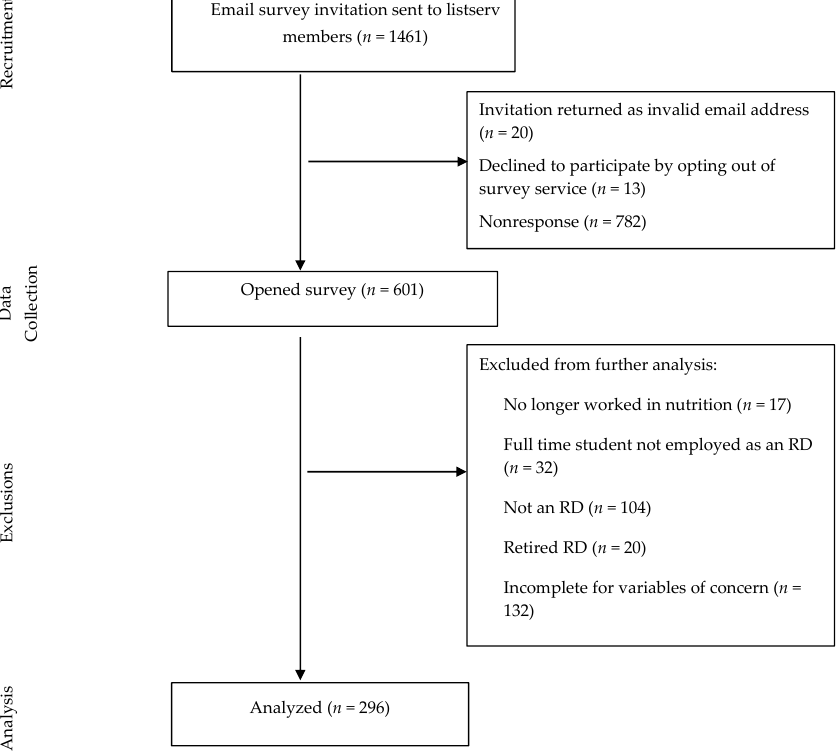
Figure 1. Consort flow diagram for participants of the Arizona Registered Dietitian Bean Health Benefits Survey